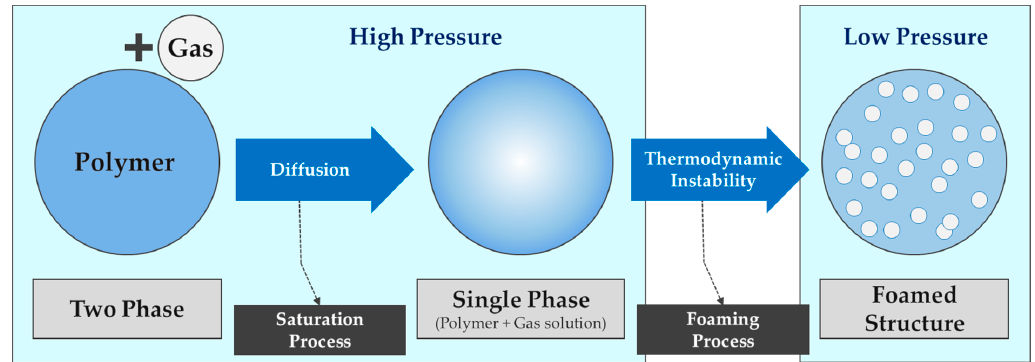
Figure 4. Schematic diagram of theoretical principle of the microcellular foaming process.